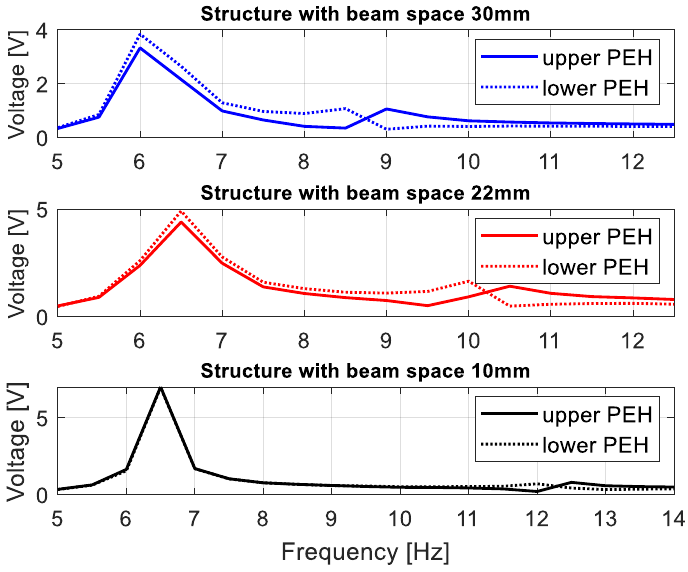
Figure 12. The comparison of the voltage generated from the top and bottom piezo-composites by various beam spaces in the structure.